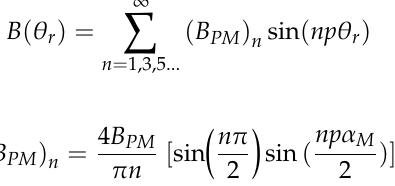
Figure 3. Ideal airgap flux density generated by the rotor surface mounted PM ( B PM ) presented over a pole-pair pitch [29].